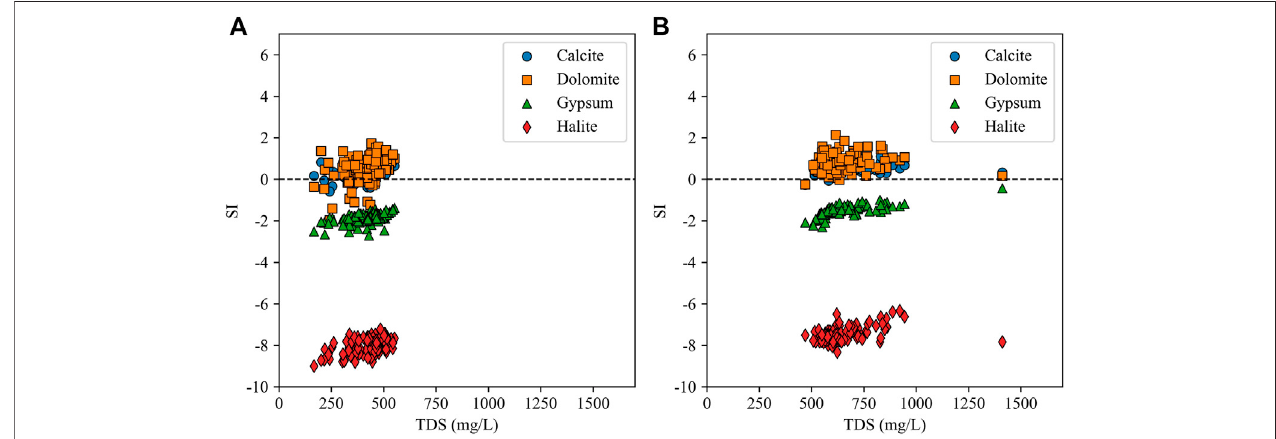
FIGURE 9 | Saturation index of calcite, dolomite, gypsum, and halite. (A) Cluster 1. (B) Cluster 2.